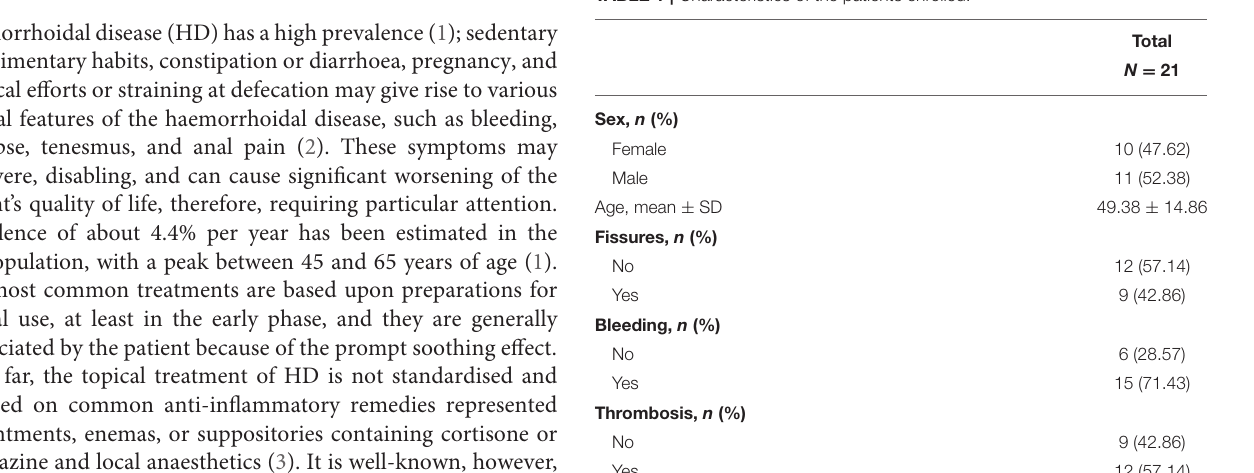
TABLE 1 | Characteristics of the patients enrolled.